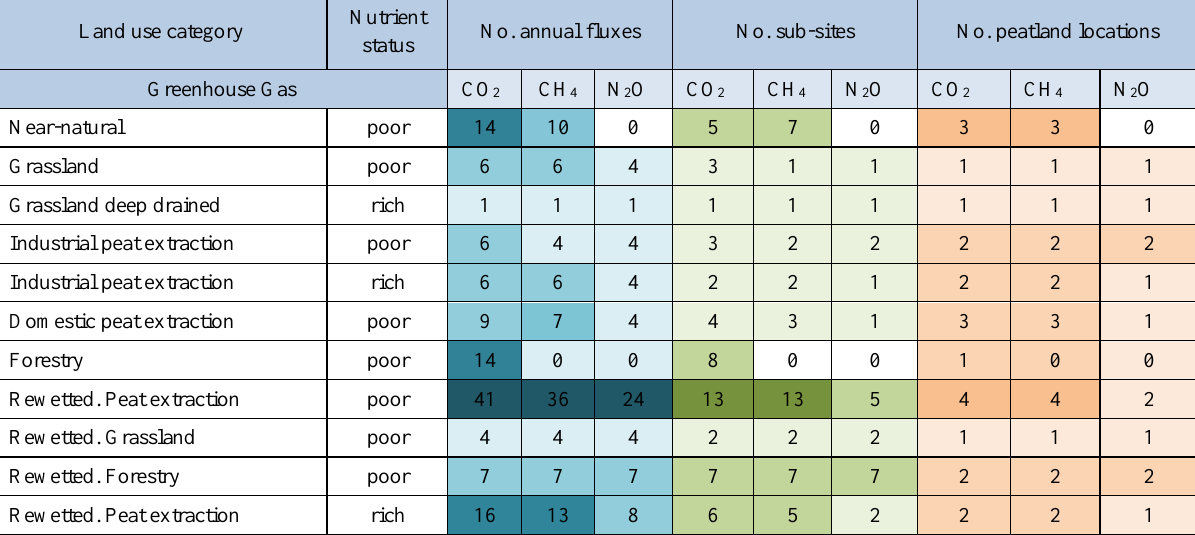
Table 1. Number of carbon dioxide (CO loss data points in Irish peatlands by land use category (LUC) and greenhouse gas (GHG) type. Data include publications up to